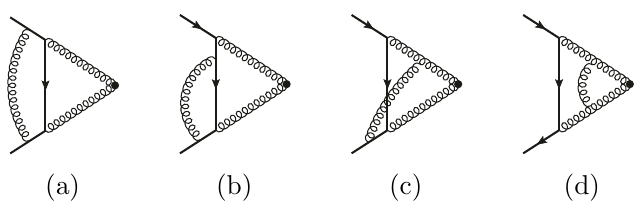
) 2 vertex (cid:22)(cid:23)